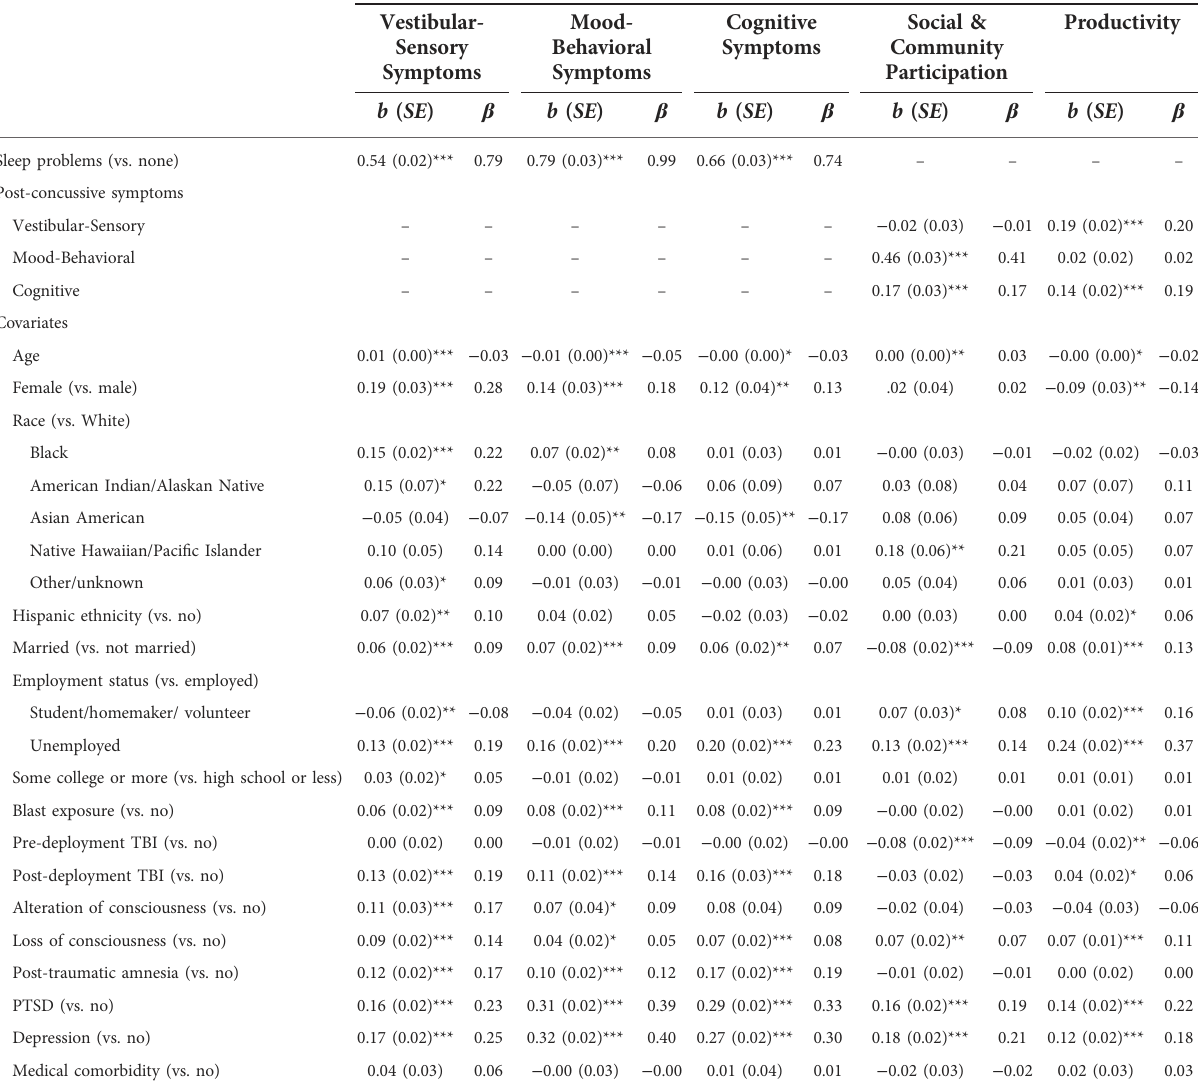
TABLE 5 Parameter estimates for fi nal latent variable path model ( n =8,733). Explanatory